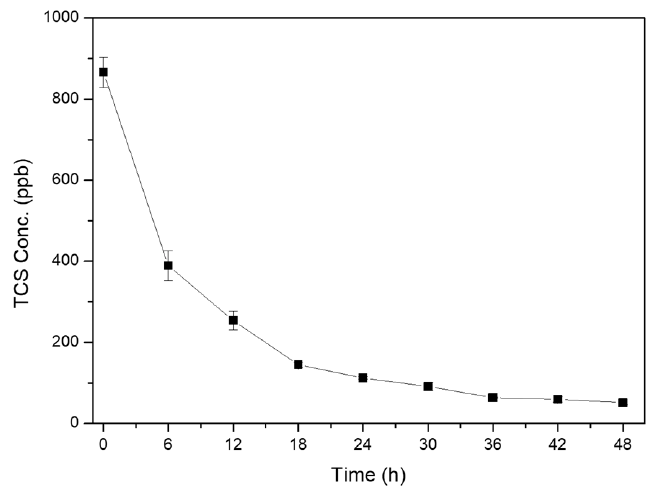
Figure 1. Reduction of Triclosan (TCS) aqueous concentration at pH 7.